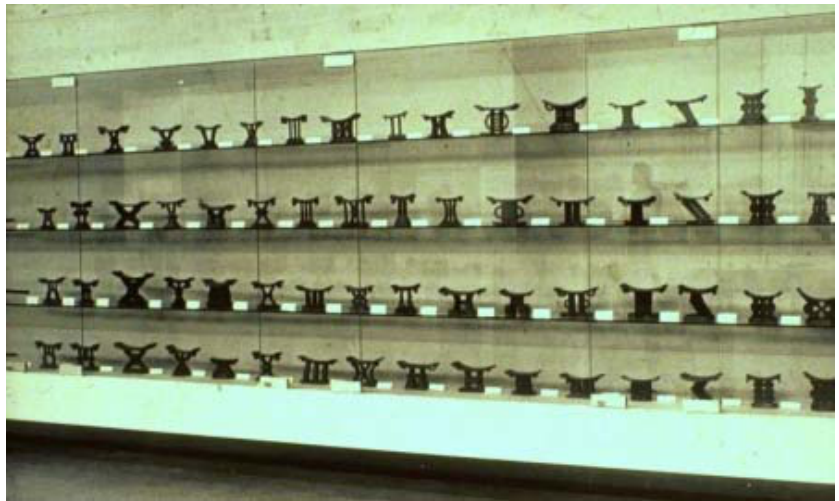
Figure 3. Display of African headrests, Johannesburg Art Gallery. Display under the direction of Karel Nel. (author’s